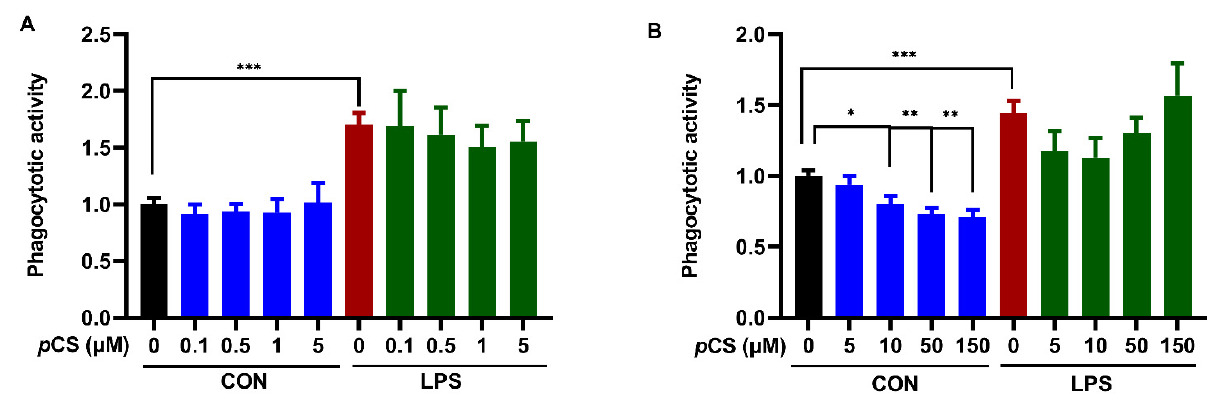
Figure 5. The effect of p CS on constitutive and LPS-induced (1000 ng/mL) phagocytosis response of BV2 microglia. ( A ) The effect of p CS (0.1, 0.5, 1, 5 µ M) on phagocytosis response of BV2 microglia ( n = 4 independent experiments). ( B ) The effect of p CS (5, 10, 50 and 150 µ M) on phagocytosis response of BV2 microglia ( n = 6 independent experiments). Black: constitutive phagocytes set on 1; red: LPS-induced phagocytosis; blue: effect of p CS on constitutive phagocytosis; green: effect of p CS on LPS-induced phagocytosis. Results were expressed as mean ± SEM. * p < 0.05, ** p < 0.01, *** p < 0.001.